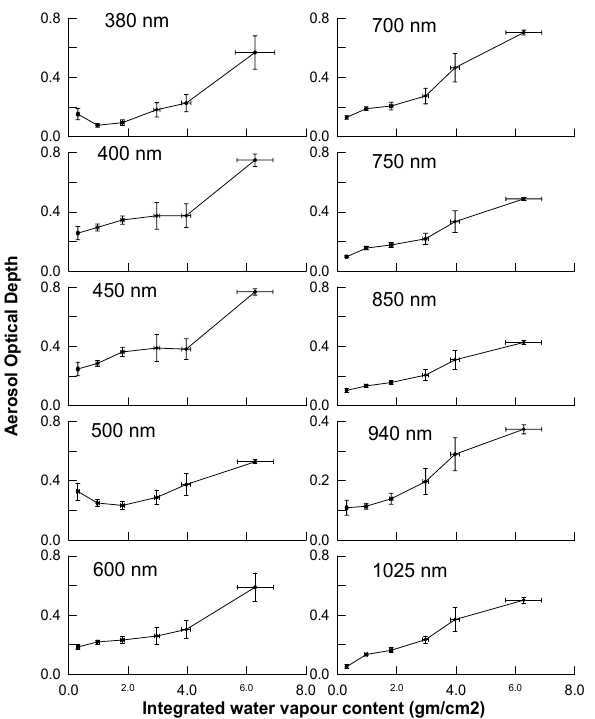
Fig. 3. Variation of mean aerosol optical depths at 10 different wavelengths as a function of columnar atmospheric water vapour content.